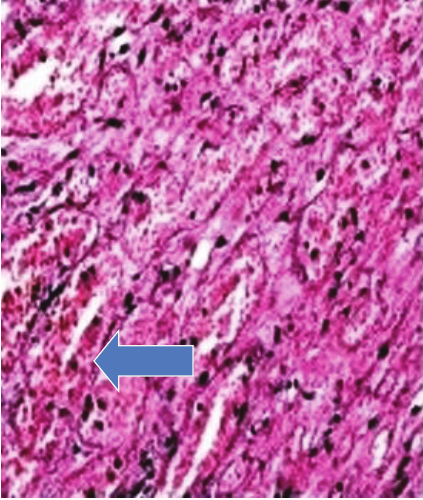
Figure 1: Transabdominal ultrasound showing echogenic large lob- ular mass suggestive of chorioangioma measuring approximately 12 × 12cm, arrow pointing to tumor.